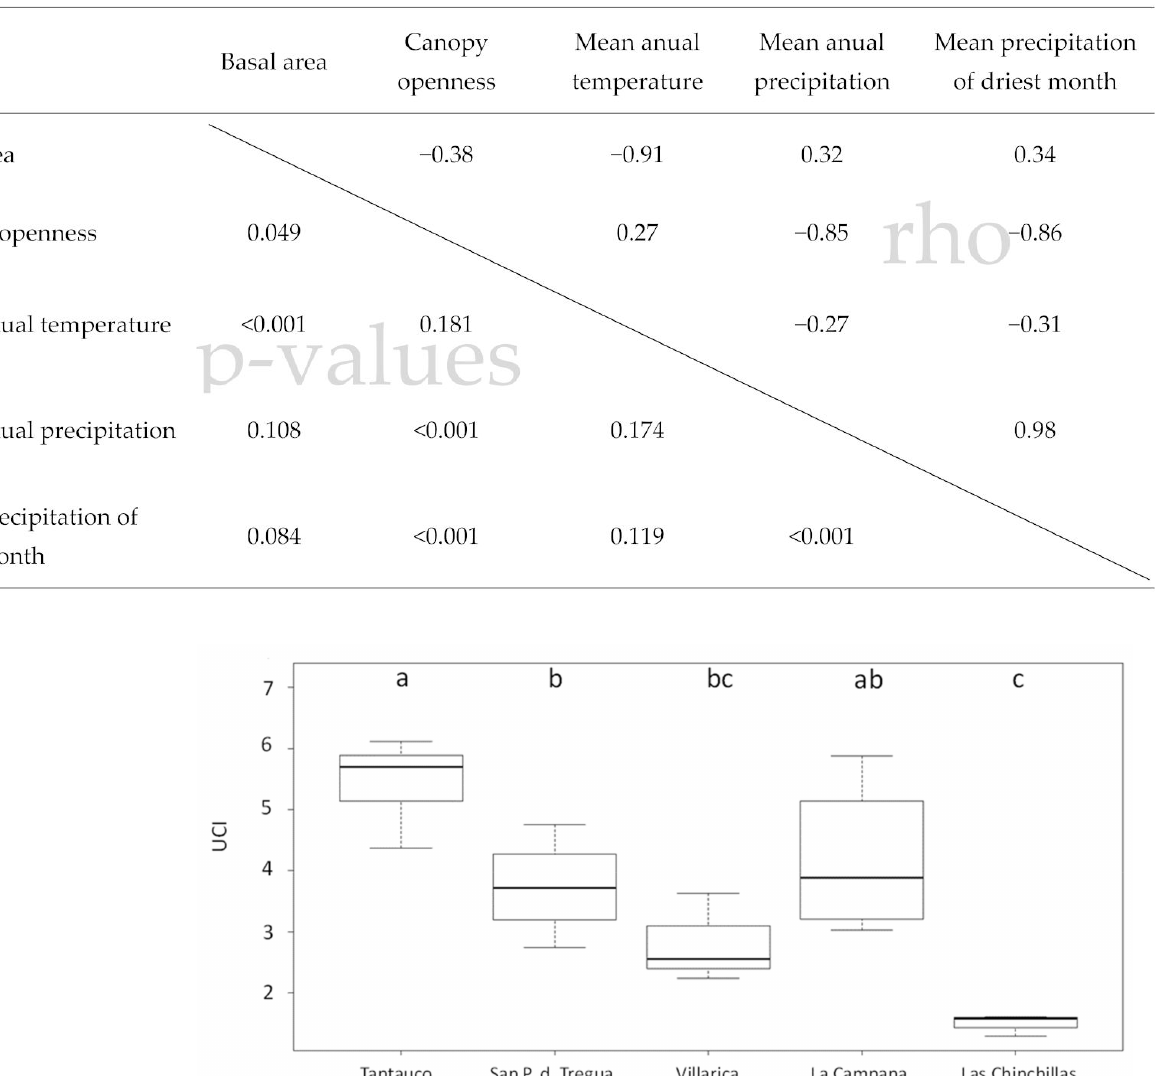
A visualization of some of the relationships is also provided in Figure 6.